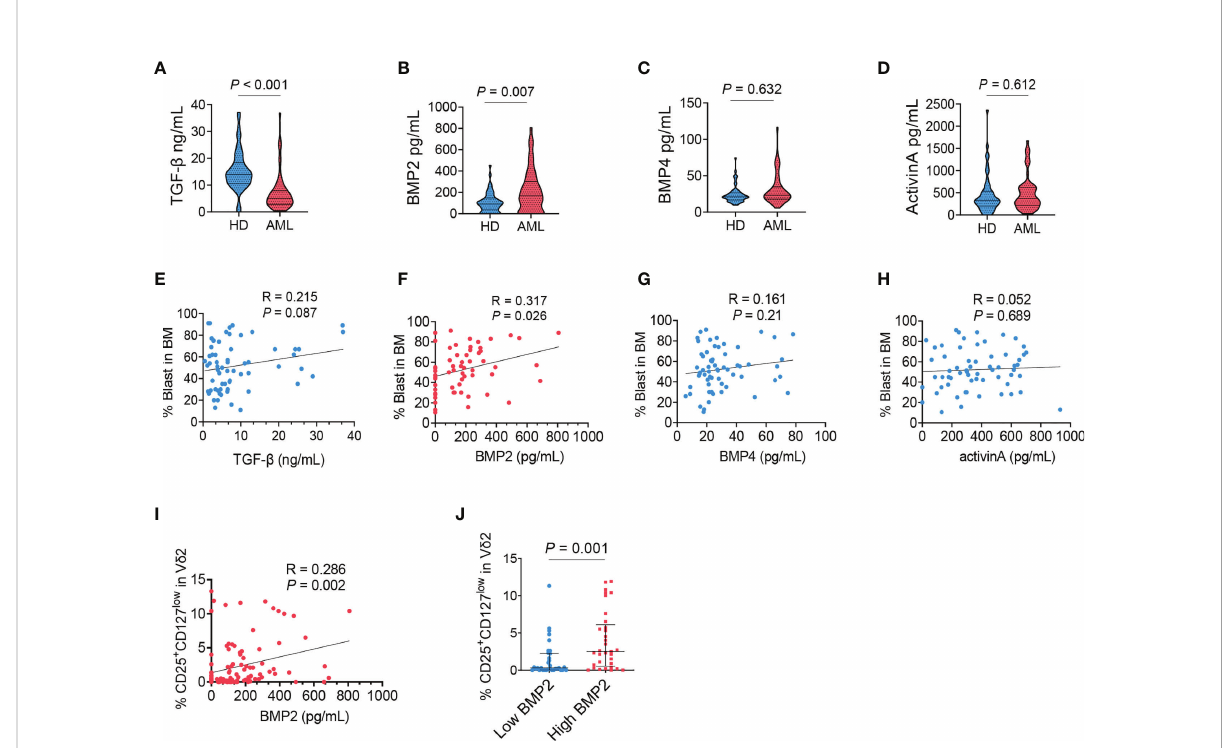
FIGURE 2 Dysregulated BMP2 in AML patients and its correlation with CD25 + CD127 low V d 2 + T cells. The supernatants of bone marrows collected from healthy donors and AML patients were detected using ELISA kit for TGF- b (A) , BMP2 (B) , BMP4 (C) and ActivinA (D) . Correlation analyses for the levels of TGF- b (E) , BMP2 (F) , BMP4 (G) , and ActivinA (H) with the load of AML blasts (n = 62). (I) Correlation analyses for the proportions of CD25 + CD127 low V d 2 + T cells with the levels of BMP2 in AML patients and healthy donors. P values are shown on the graphs respectively. (J) Comparison of the frequency of CD25 + CD127 low V d 2 + T cells in AML patients with ≤ median (low) and > median (high) concentrations of BMP2. P values are shown on the graphs